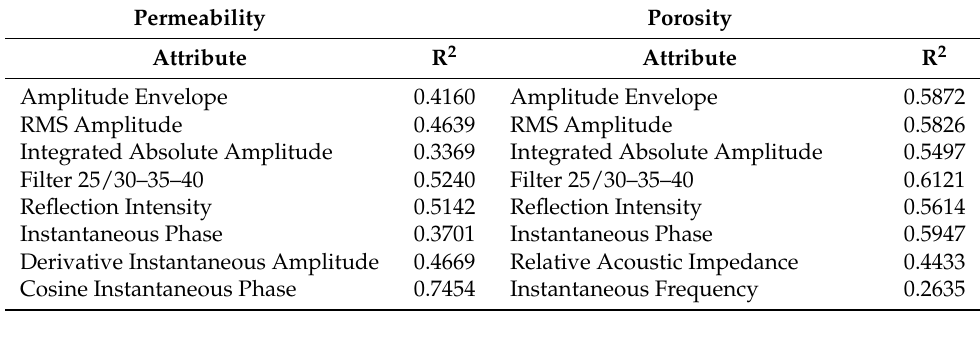
Table 9. The selected input attributes for estimating permeability and porosity.